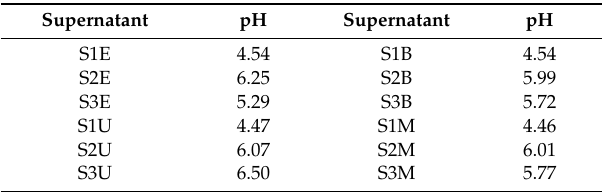
Table 1. pH values of